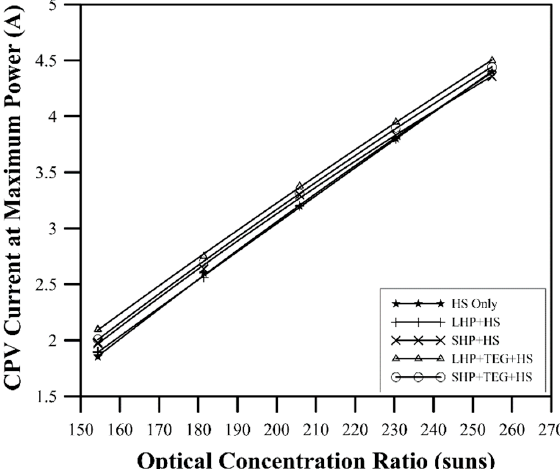
Figure 6. Increase of the CPV current at maximum power as a function of the optical concentration ratio for the five different operating modes.